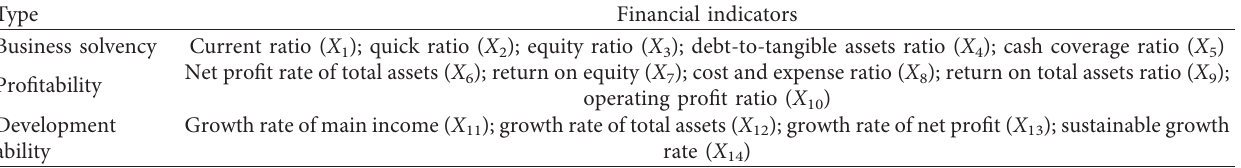
Table 1: Initial financial indicator system.